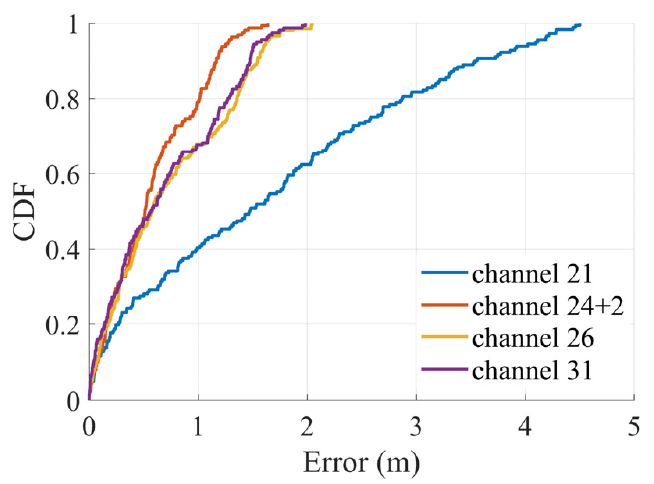
Figure 10. Ranging error CDF in dynamic tests.